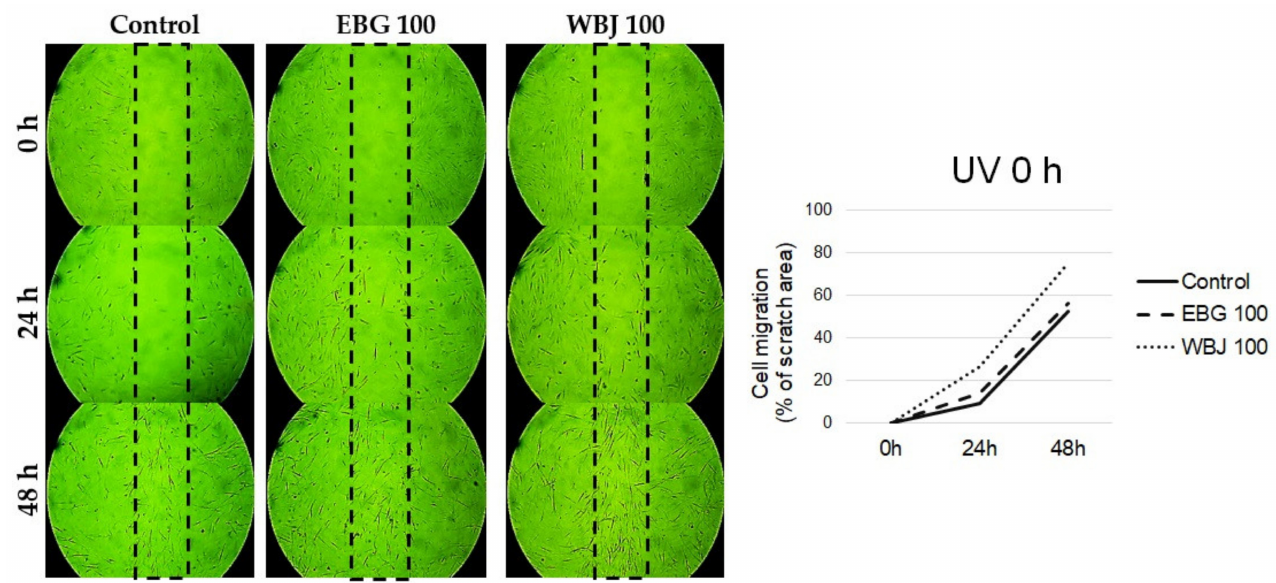
Figure 13. Effect of 70% ethanolic extract of barley grass (EBG) and 100 µ g/mL water extract of young barley juice (WBJ) on the migration of NHSF cell line in “UV 24 h” model.